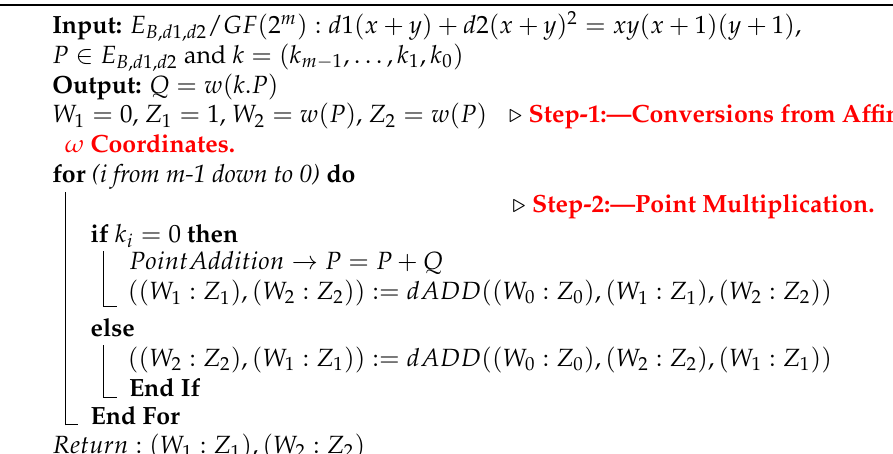
Algorithm 1: Montgomery point multiplication algorithm